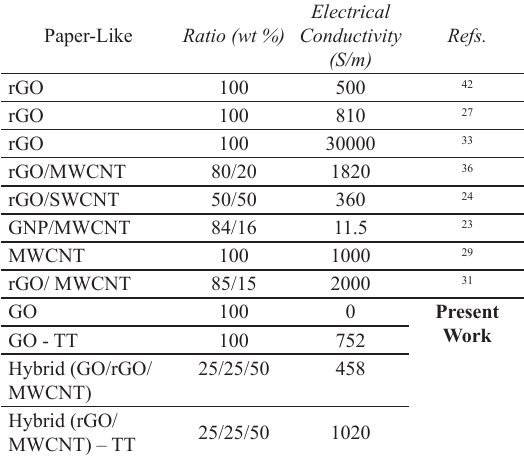
Table 4. Comparison of the electrical conductivity results obtained for the graphene paper-likes in the literature with this work Electrical Paper-Like Ratio (wt %) Conductivity